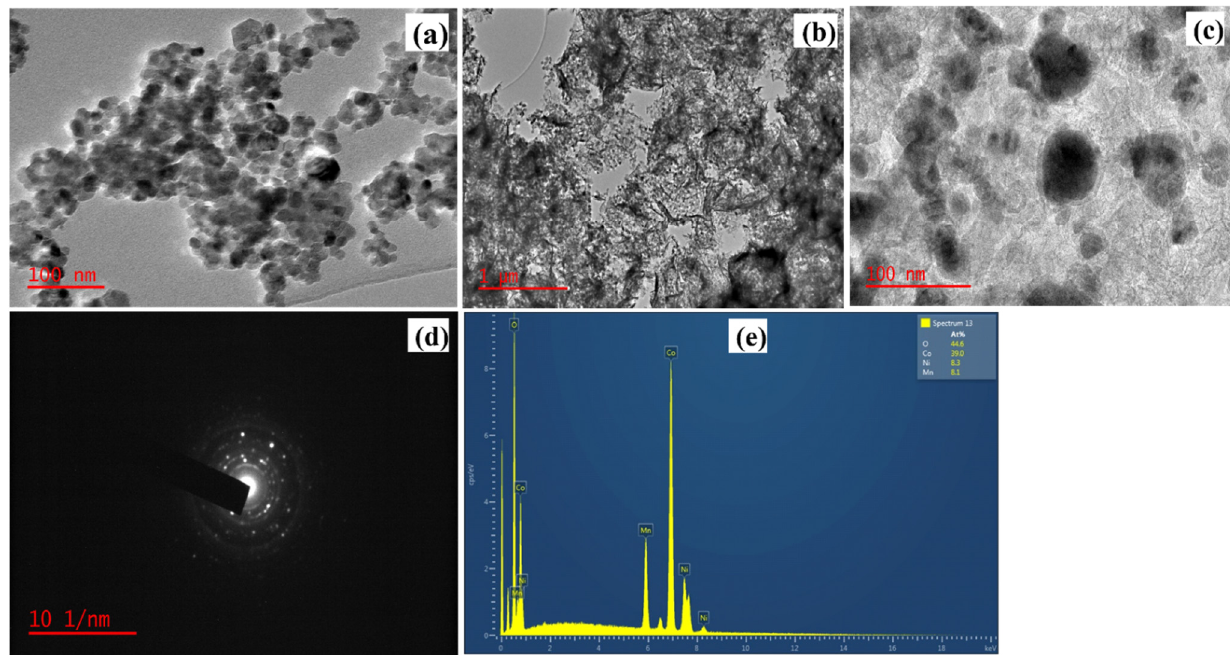
Figure 5. ( a ) TEM image of Mn 0.5 Ni 0.5 Co 2 O 4 , ( b , c ) TEM of images of Mn 0.5 Ni 0.5 Co 2 O 4 /C at different magnifications, ( d ) SAED pattern of Mn 0.5 Ni 0.5 Co 2 O 4 /C, ( e ) EDS spectrum of Mn 0.5 Ni 0.5 Co 2 O 4 N 2 adsorption/desorption analysis was used to evaluate the specific surface areas and the pore sizes and volume of Mn x Ni 1 − x Co 2 O 4 and Mn 0.5 Ni 0.5 Co 2 O 4 /C.